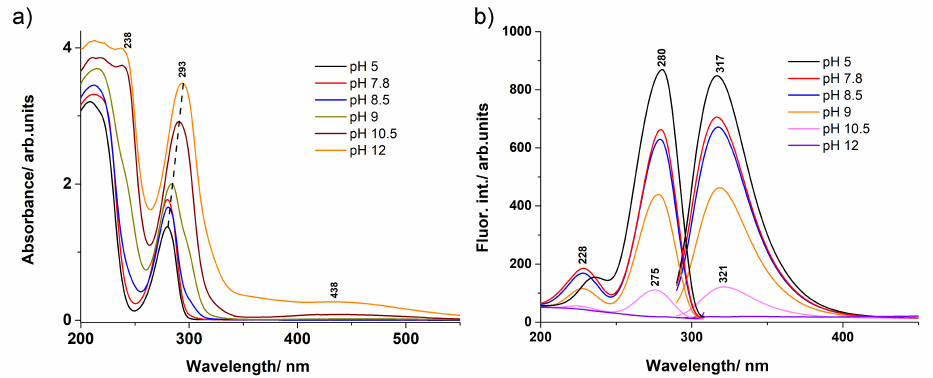
Figure 2. ( a ) The experimental UV absorption spectra obtained for aqueous DA solutions prepared having different pH values of the solution. ( b ) The fluorescence emission and excitation spectra obtained for aqueous DA solutions with different pH values.